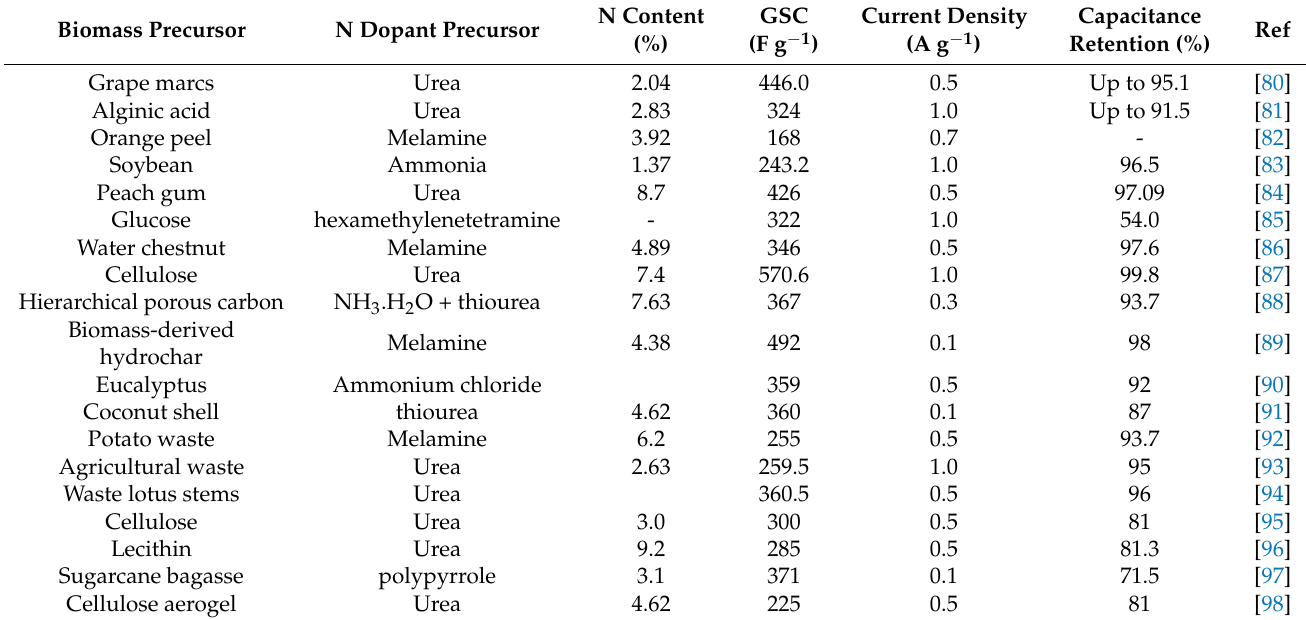
Table 2. − N-doped biomass-derived carbon electrodes for